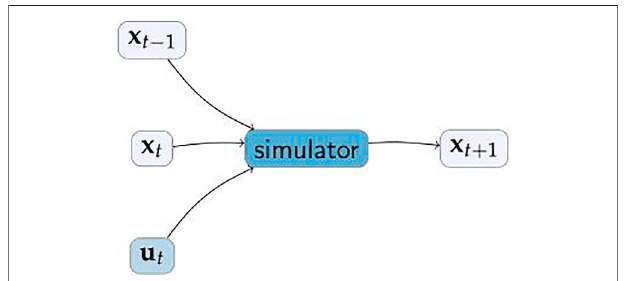
FIGURE3| Simulatorisphrasedasarecursivefunction,whichistrained with one-step examples.